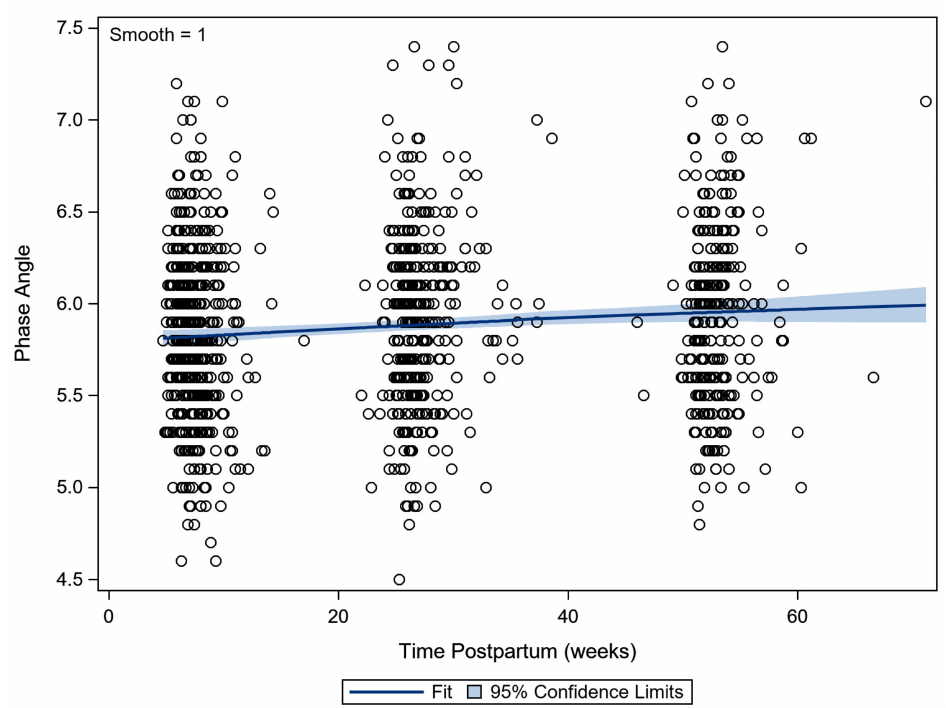
Figure 2. Scatterplot of the phase angle in the 1st year postpartum. A lowess smoother (with 95% confidence limits) indicated the evolution over time (lowess—locally weighted scatterplot